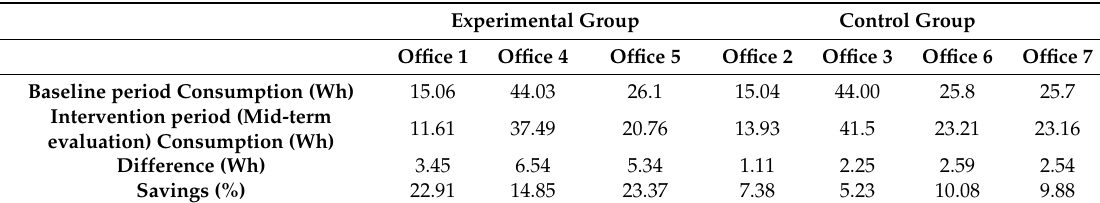
Table 4. Total consumption in Wh during the 21 days of baseline period, during the 22 days of the experiment (Mid-term evaluation), difference in the consumption and savings between the two periods.